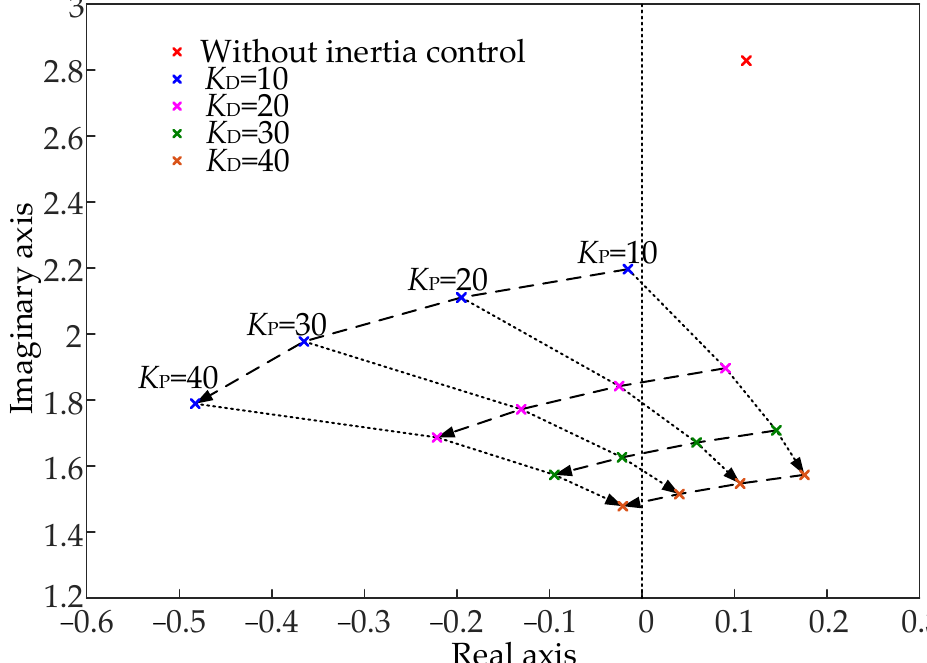
Figure 3. Eigenvalue analysis results of the LFO mode under different control gains.